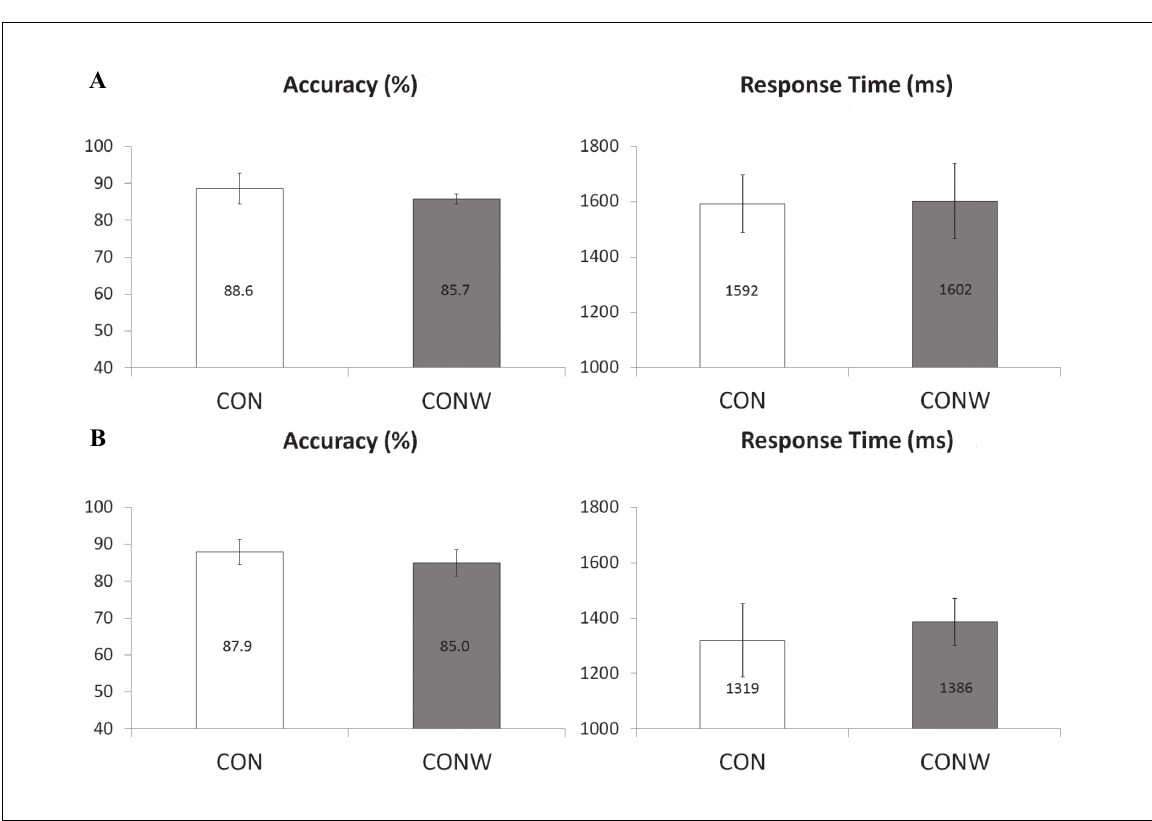
Figure 3. Accuracy (%) and response times (milliseconds) in (A) mathematical processing and (B) spatial processing (simultaneous)